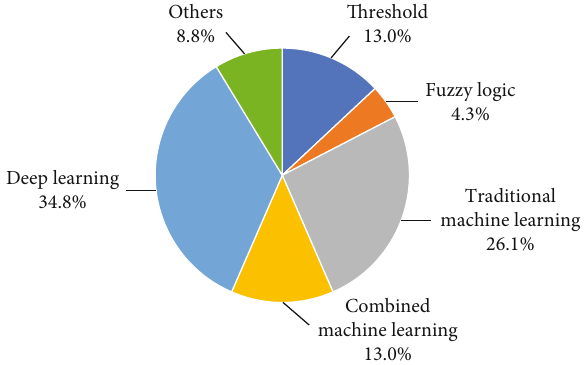
Figure 7: The distribution of detection algorithm in the reviewed